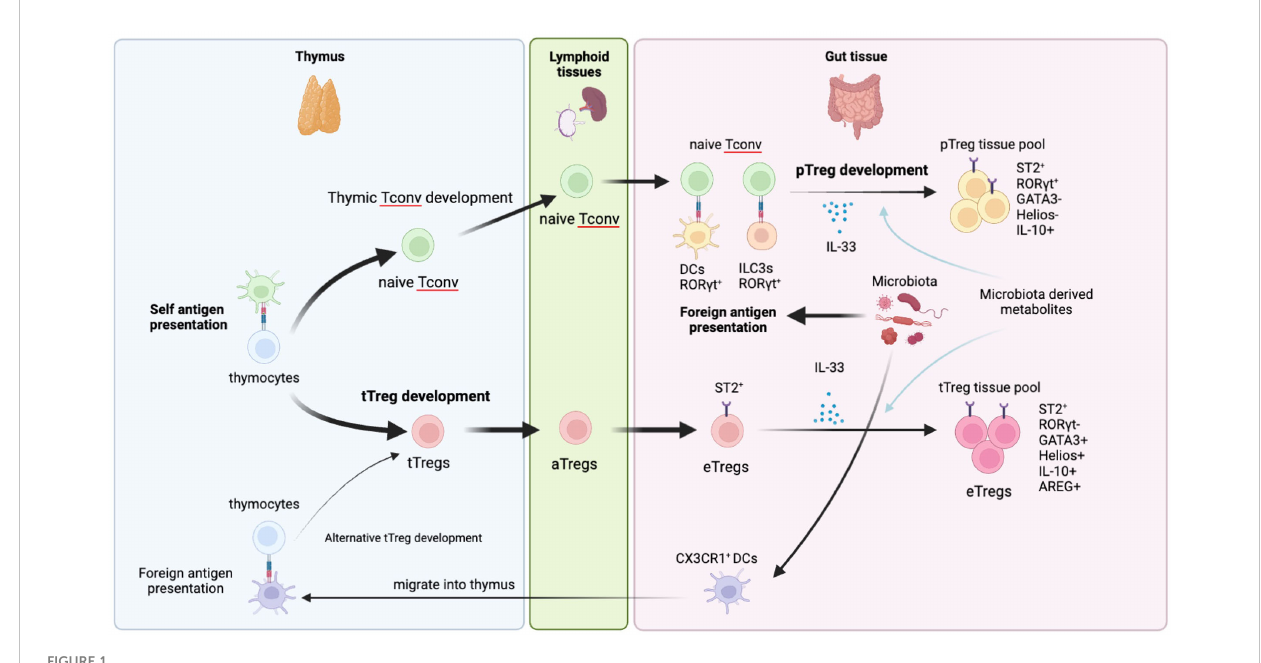
FIGURE 1 Development of gut tTregs and pTregs. Gut Tregs are composed of tTreg and pTreg pools. tTregs are generally developed in the thymus and preferentially recognize self-antigen. After leaving the thymus, tTregs are activated in secondary lymphoid organs and further differentiate into eTregs in the gut tissue by receiving IL-33 and environmental cues such as microbiota and metabolites. Gut tTregs preferentially express Helios, GATA3 but not ROR g t. Recently, an alternative tTreg developmental path has been reported. CX3CR1 + DCs in the intestine can migrate into thy thymus and present antigens of commensal microbiota to thymocytes to differentiate them into tTregs. Those tTregs harbor TCRs that can recognize foreign antigen and migrate into the gut to establish peripheral tolerance. pTregs are developed from naïve CD4 + Tconv stimulated by foreign antigens presented by ROR g t + DCs and/or ROR g t + ILC3s in the gut draining lymph nodes and further activated in the gut tissue to acquire suppressive effector Treg features. pTregs preferentially express ROR g t but not GATA3 and